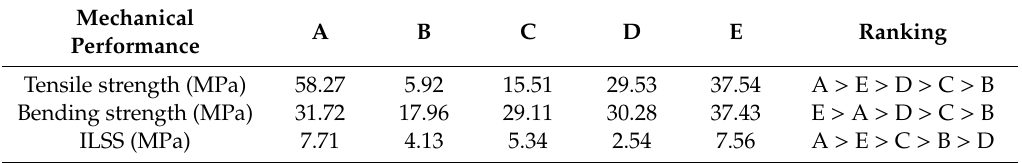
Table 6. The ranges of mechanical performance in the orthogonal